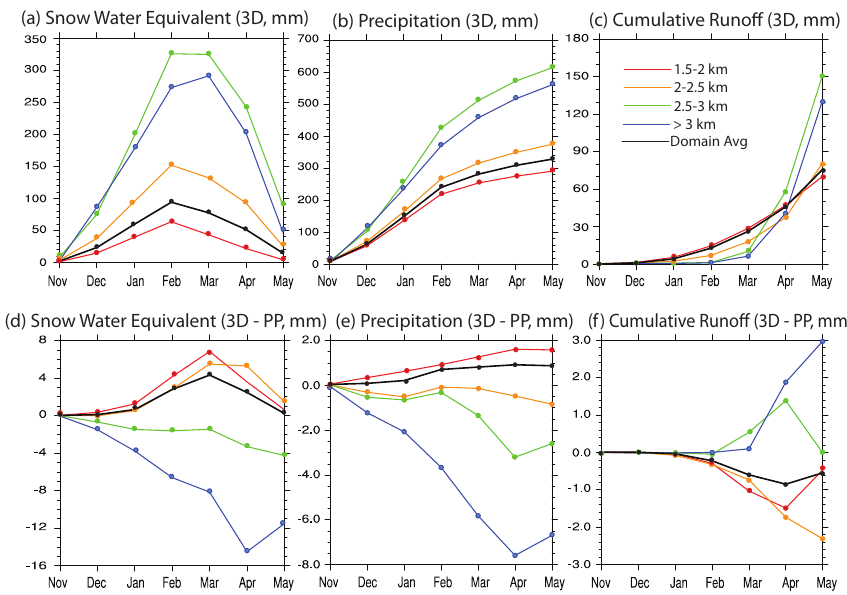
Fig. 12 Fig. 12. (a) The monthly mean snow water equivalent (SWE, mm) averaged over the simulation domain as a function of elevation. (b) The monthly mean precipitation (mm) averaged over the simulation domain as a function of elevation. (c) The monthly mean cumulative runoff averaged over the simulation domain as a function of elevation. (d) The corresponding SWE deviations (3-D-PP). (e) The correspondence precipitation deviations (3-D-PP). (f) The correspondence runoff deviations (3-D-PP). 1.5–2km (red), 2–2.5km (orange), 2.5–3m (green), above 3km (blue), and the whole domain